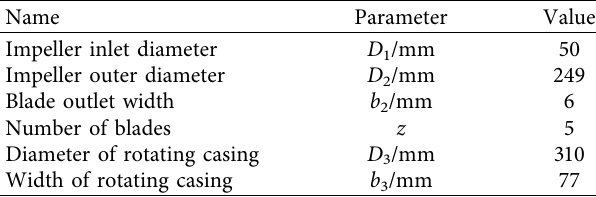
Table 1: Geometrical parameters of the test